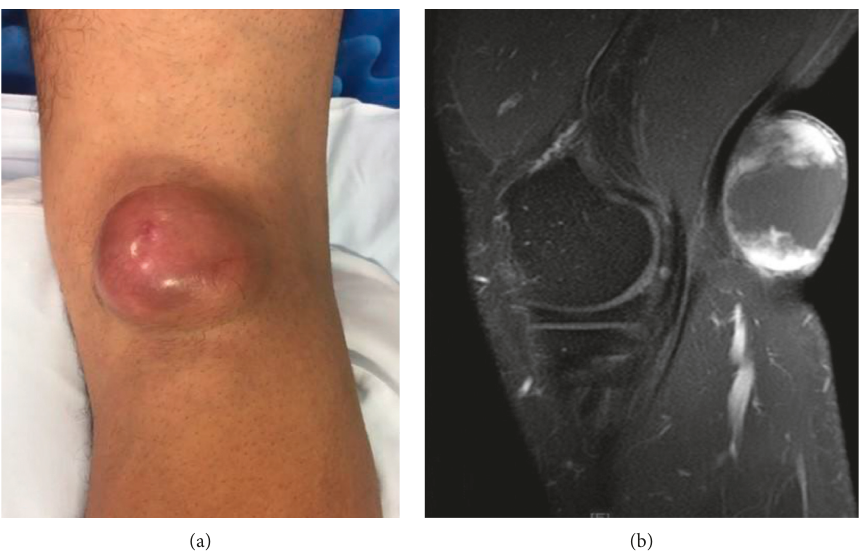
Figure 1: The image shows a 40-year-old male with a painless, superficial popliteal mass seen on (a) physical examination and (b) magnetic resonance imaging. In-office biopsy results showed intermediate-grade soft tissue sarcoma of indeterminate type. Final surgical pathology results showed grade 2